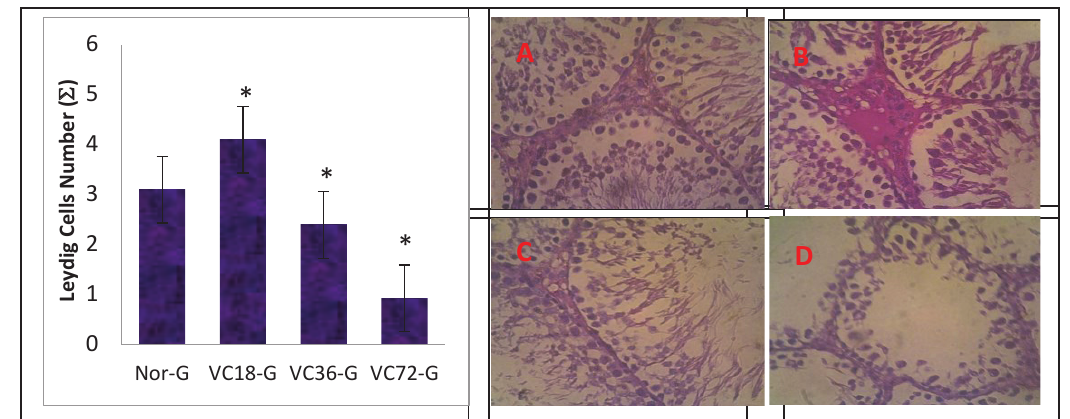
Figure 2. Leydig Cells Number in each Group. A: Nor-G; B: VC-18-G; C: VC36-G; D: VC72-G. * p < 0.05 Nor-G as a